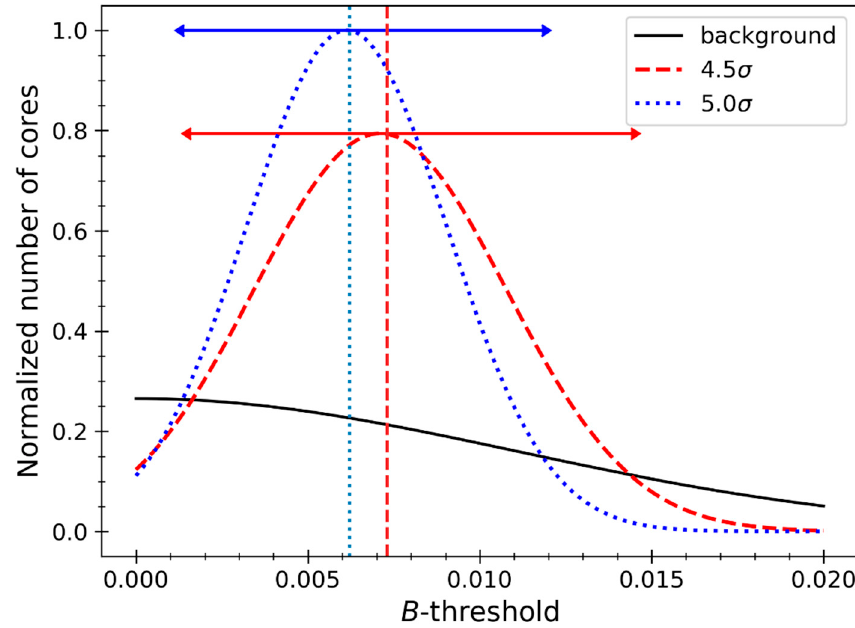
Figure 10. Probability of detection as a function of the threshold.